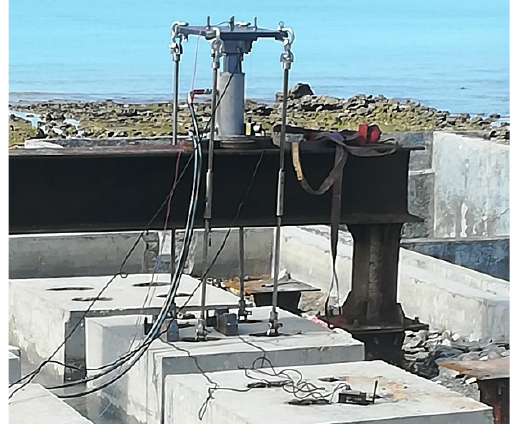
Figure 18. Vertical jack loading of Hg specimen.